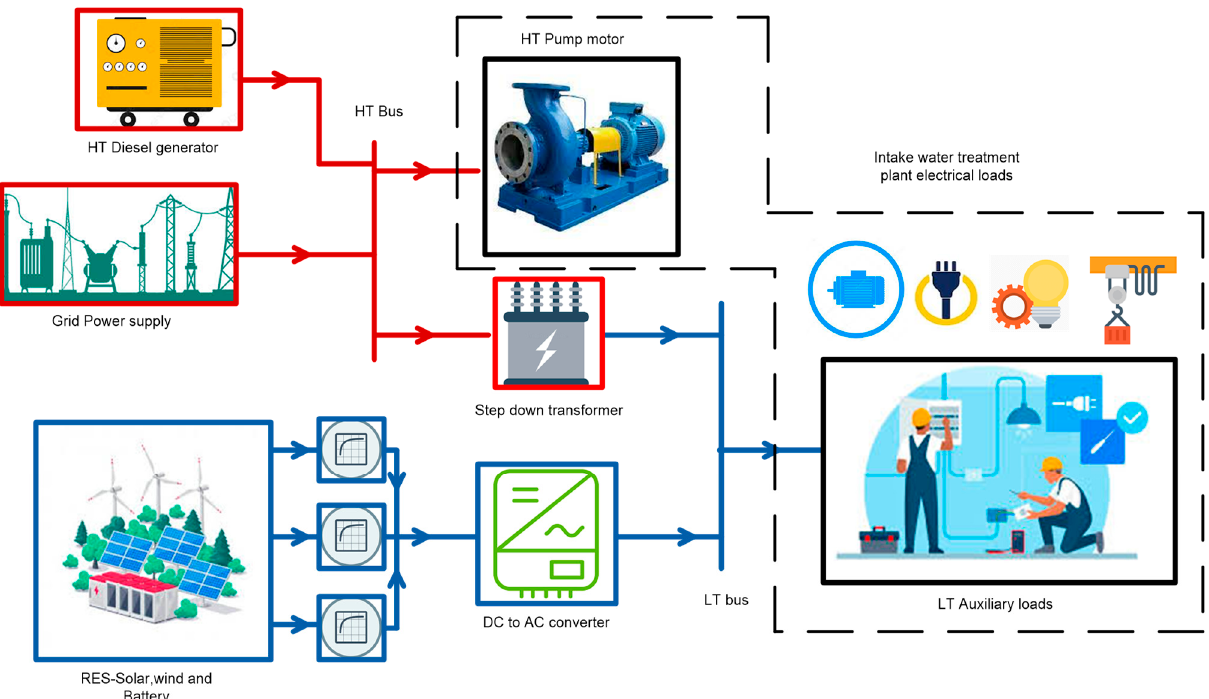
Figure 3. Single line configuration of the proposed microgrid system.